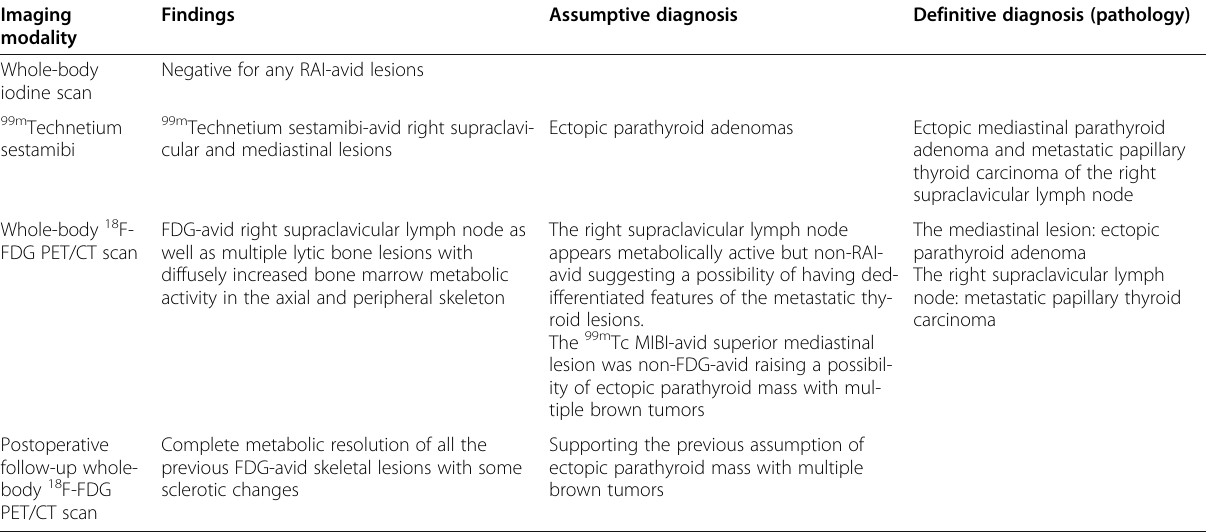
Table 1 Summary of the main nuclear imaging findings and the assumptive